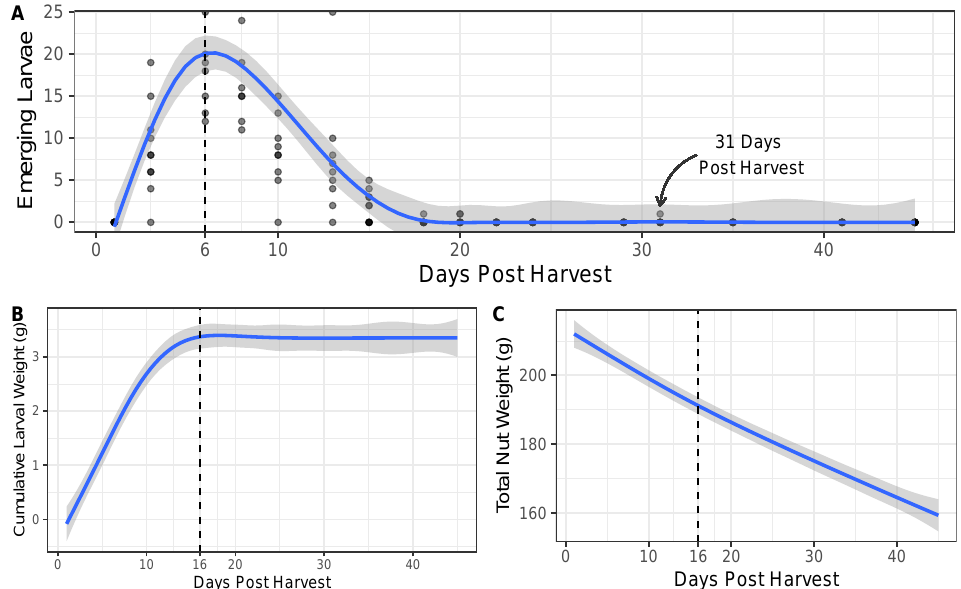
Figure 2. Larval C. sayi damage on groups of chestnuts. ( A ) Number of emerging larvae from 1 L planting containers of chestnuts. ( B ) Cumulative weight of all emerging larvae emerging from each 1 L planting container of chestnut. ( C ) Total weight of chestnuts in each 1 L planting container of chestnuts. For all plots: points denote individual observations; blue lines and shaded areas denote generalized additive model smoothed fit and 95% confidence intervals,